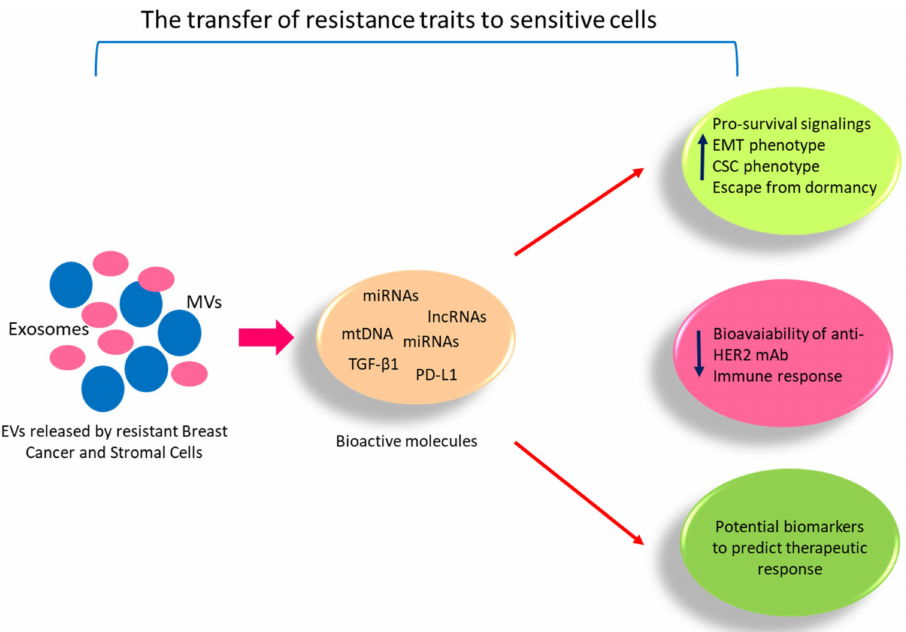
Figure 2. The proposed function of EVs secreted by breast cancer or stromal cells in endocrine treatment resistance. EVs, by transferring their cargo in sensitive breast cancer cells, can confer traits of hormonal resistance by inducing signaling pathways involved in survival, migration, invasion, epithelial mesenchymal transition (EMT), in sustaining the cancer stem cell-like (CSC) phenotype and escape from dormancy. EVs can reduce the bioavailability of anti-HER2 mAb and immune evasion promoting resistance to targeted therapy to overcome endocrine therapies’ failure. Finally, evaluation of the molecular cargo of circulating EVs has promising value to discover potential biomarkers to predict the therapeutic response in ER-positive breast cancer